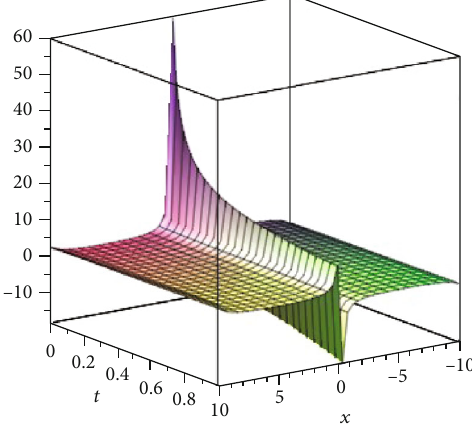
ð x , t Þ of Equation Figure 9: u 1,3